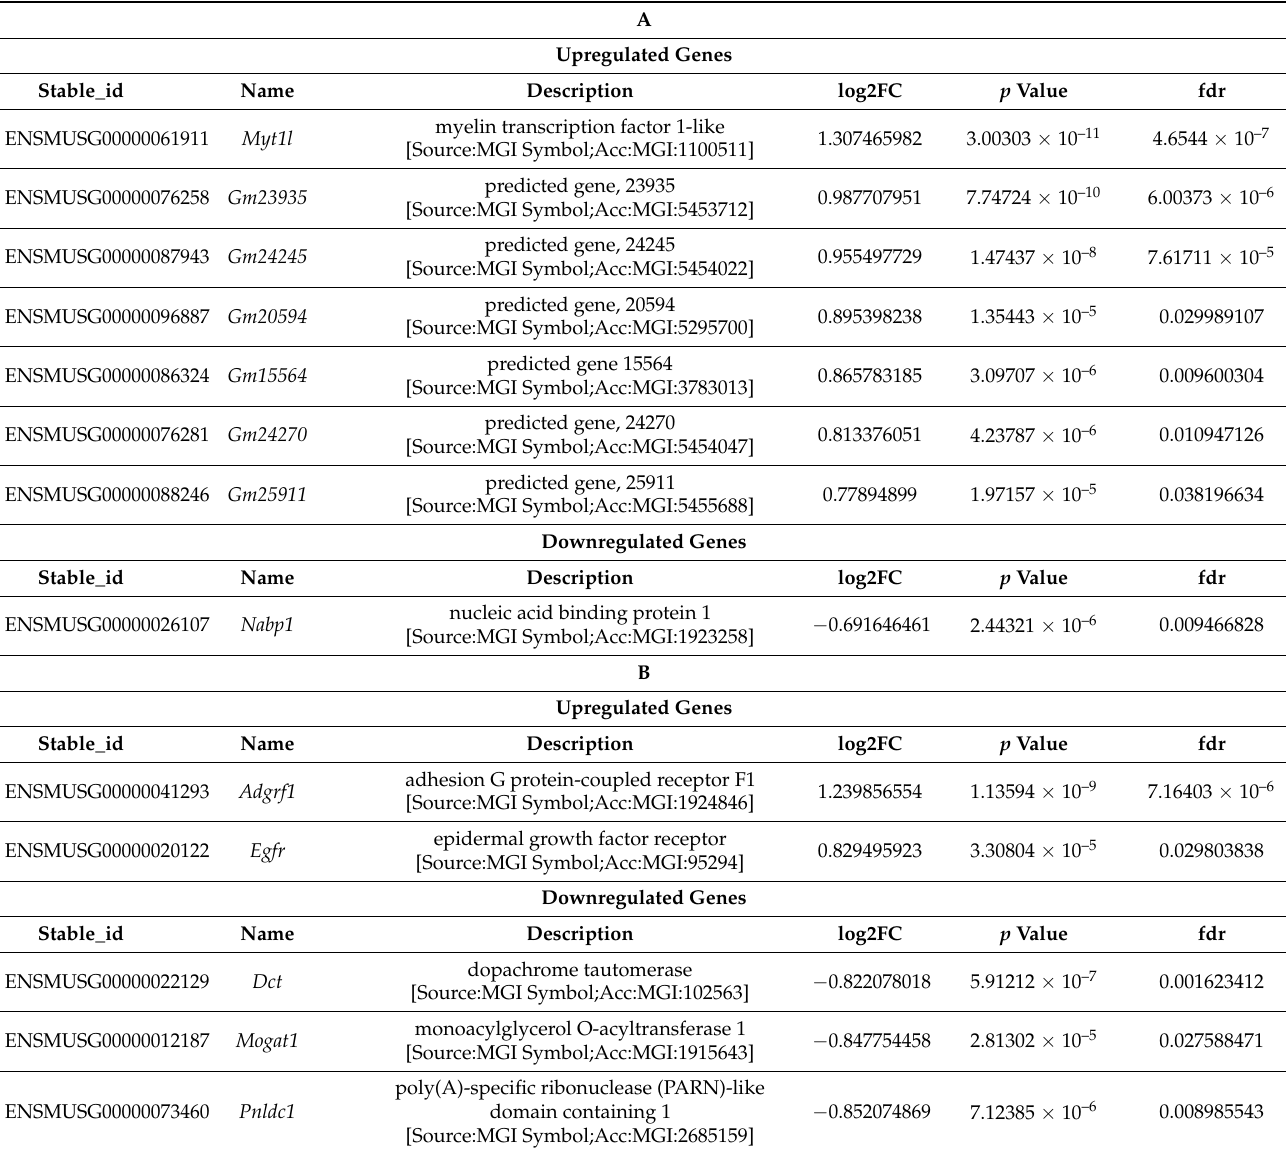
Table 2. Comparative (control vs. CTRP-3 KO mice) transcriptome sequencing by RNA-Seq of primary mature adipocytes (isolated from intra-abdominal adipose tissue) ( A ) and total liver tissue ( B